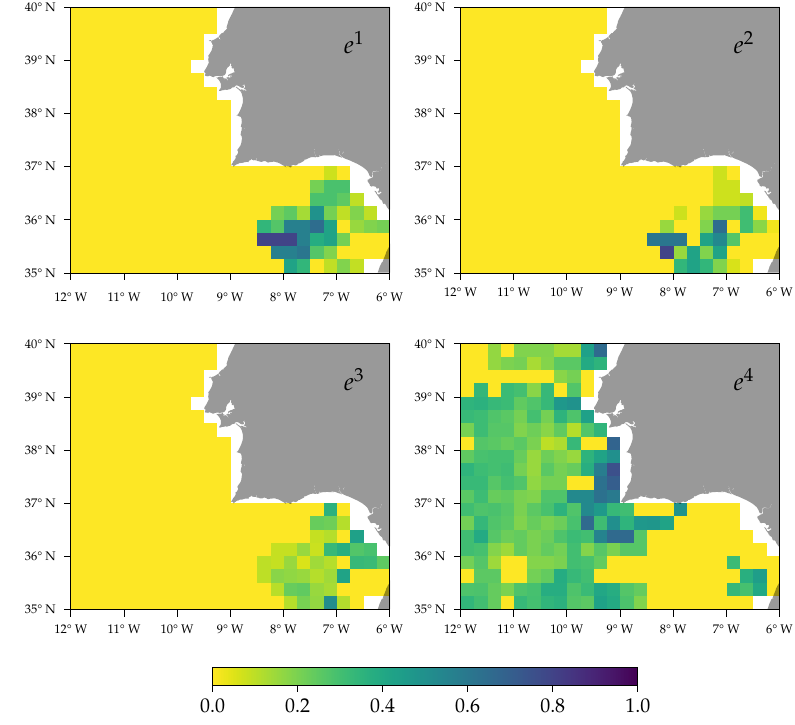
Figure 6. Scores given to each square of the grid for each type of